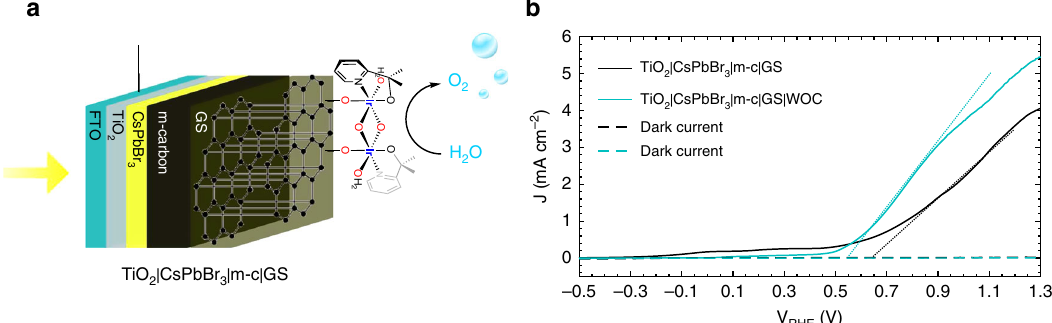
Fig. 6 TiO 2 |CsPbBr 3 |m-c|GS|WOC as solar cell and photoanode. a Schematic illustration of the CsPbBr 3 photoanode for PEC O 2 evolution: TiO 2 |CsPbBr 3 |m- c|GS|WOC uses commercial conductive GS functionalised with an Ir-based catalyst. The photoanode is illuminated from the back side. b Linear sweep voltammetry (LSV) of a TiO 2 |CsPbBr 3 |m-c|GS and a TiO 2 |CsPbBr 3 |m-c|GS|WOC measured at a scan rate of 20 mV s − 1 , in a 0.1 M KNO 3 electrolyte solution with pH 2.5 (pH adjusted with H 2 SO 4 ) Supplementary Fig. 26 and Supplementary Note 5. Figure 8b shows the Faradaic ef fi ciency of the light-driven water oxidation, which reached values as high as 82.3% using this unoptimised